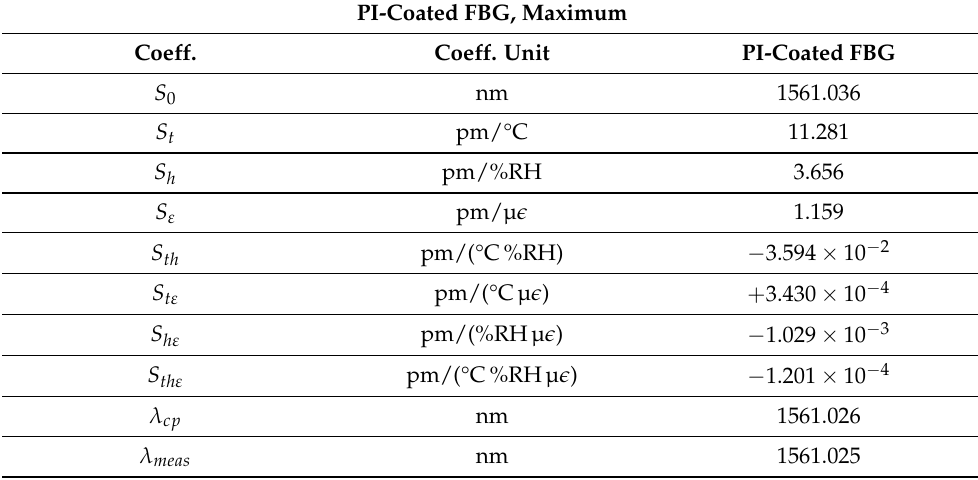
Table 2. Factorial design experiment results; main sensitivities: S t , S h , S ε , and cross